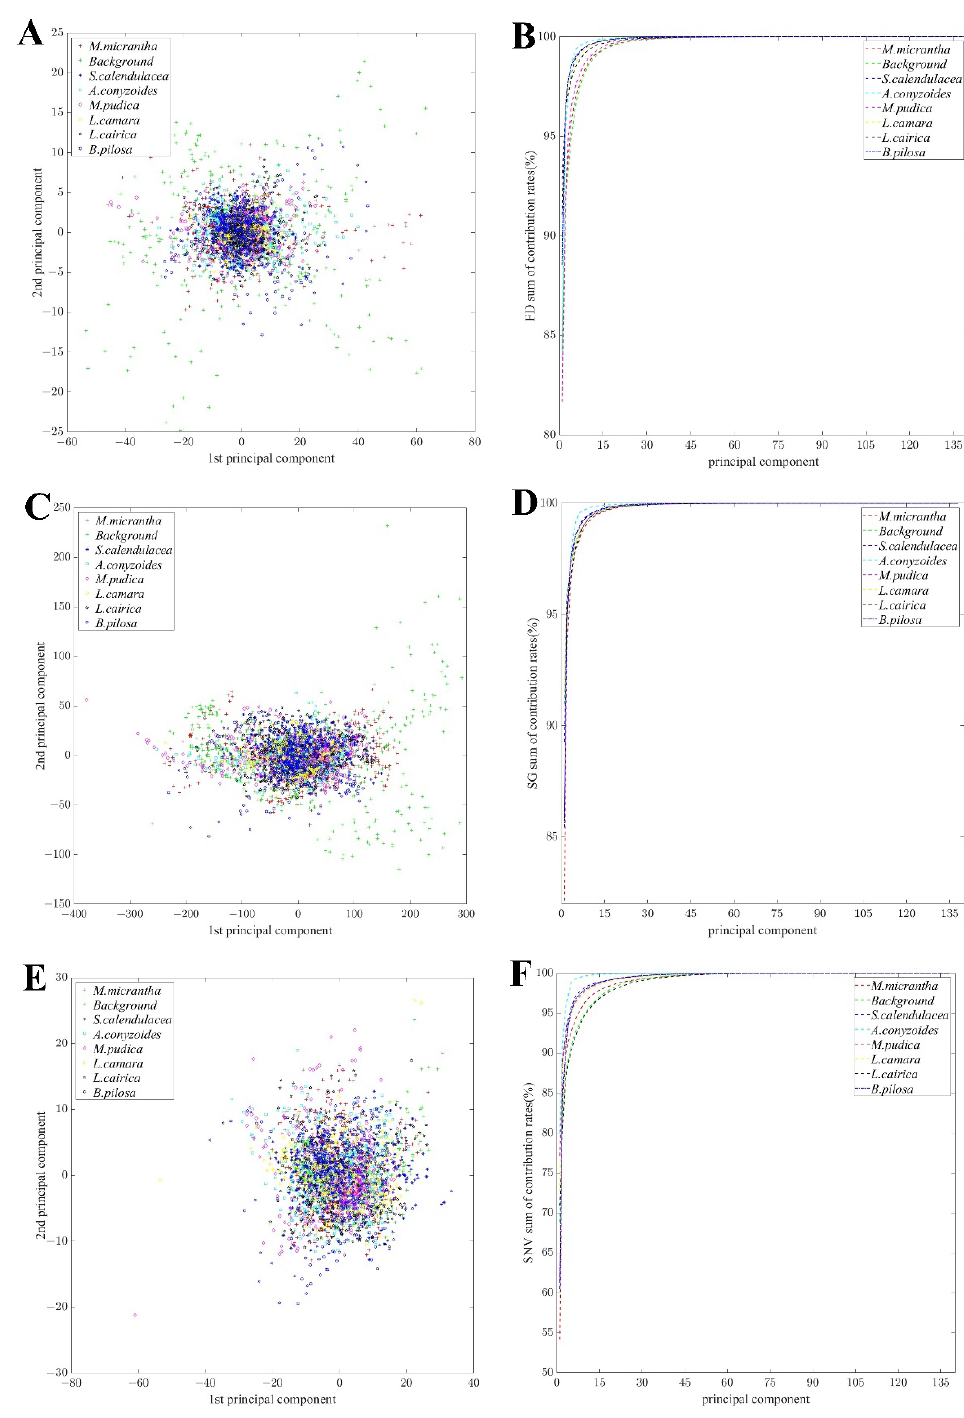
Figure 4. First and second principal component scores and cumulative contribution rate curve of the principal components of 3359 samples based on ( A ) ( B ) first derivative, ( C ) ( D ) SG smoothing, ( E ) ( F ) standard normal variable transformation.